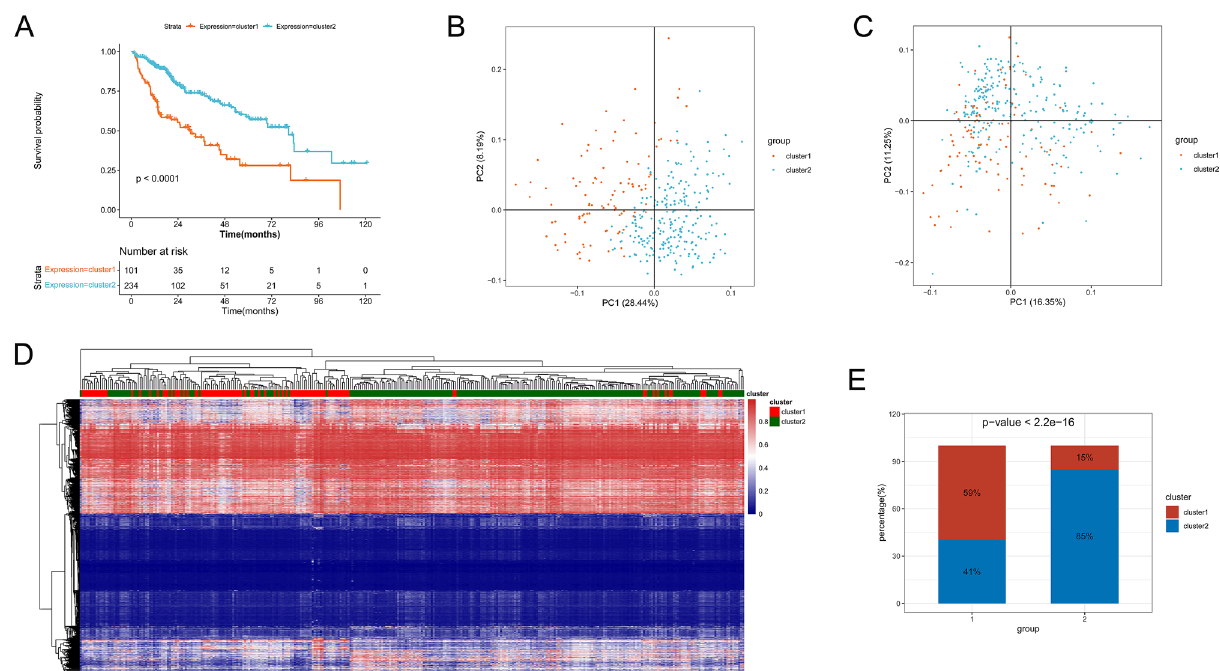
Figure 2. Identification of prognostic molecular subtype. ( A ): Survival and prognosis of the two subtypes. ( B ) Principal component analysis (PCA) of mRNA expression pattern, ( C ) methylation pattern. ( D ) Heatmap of the reuslts of hierarchical clustering analysis. ( E ) The differences onmethylation pattern of clusters between groups 1 and